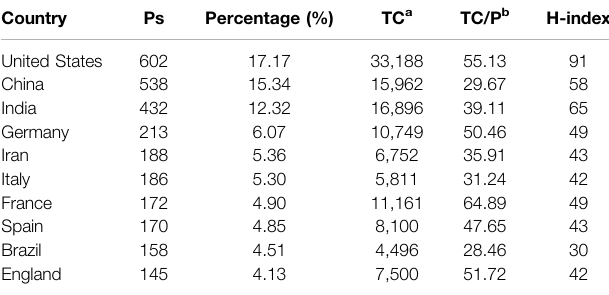
TABLE 2 | Top 10 most productive countries in terms of relevant articles.